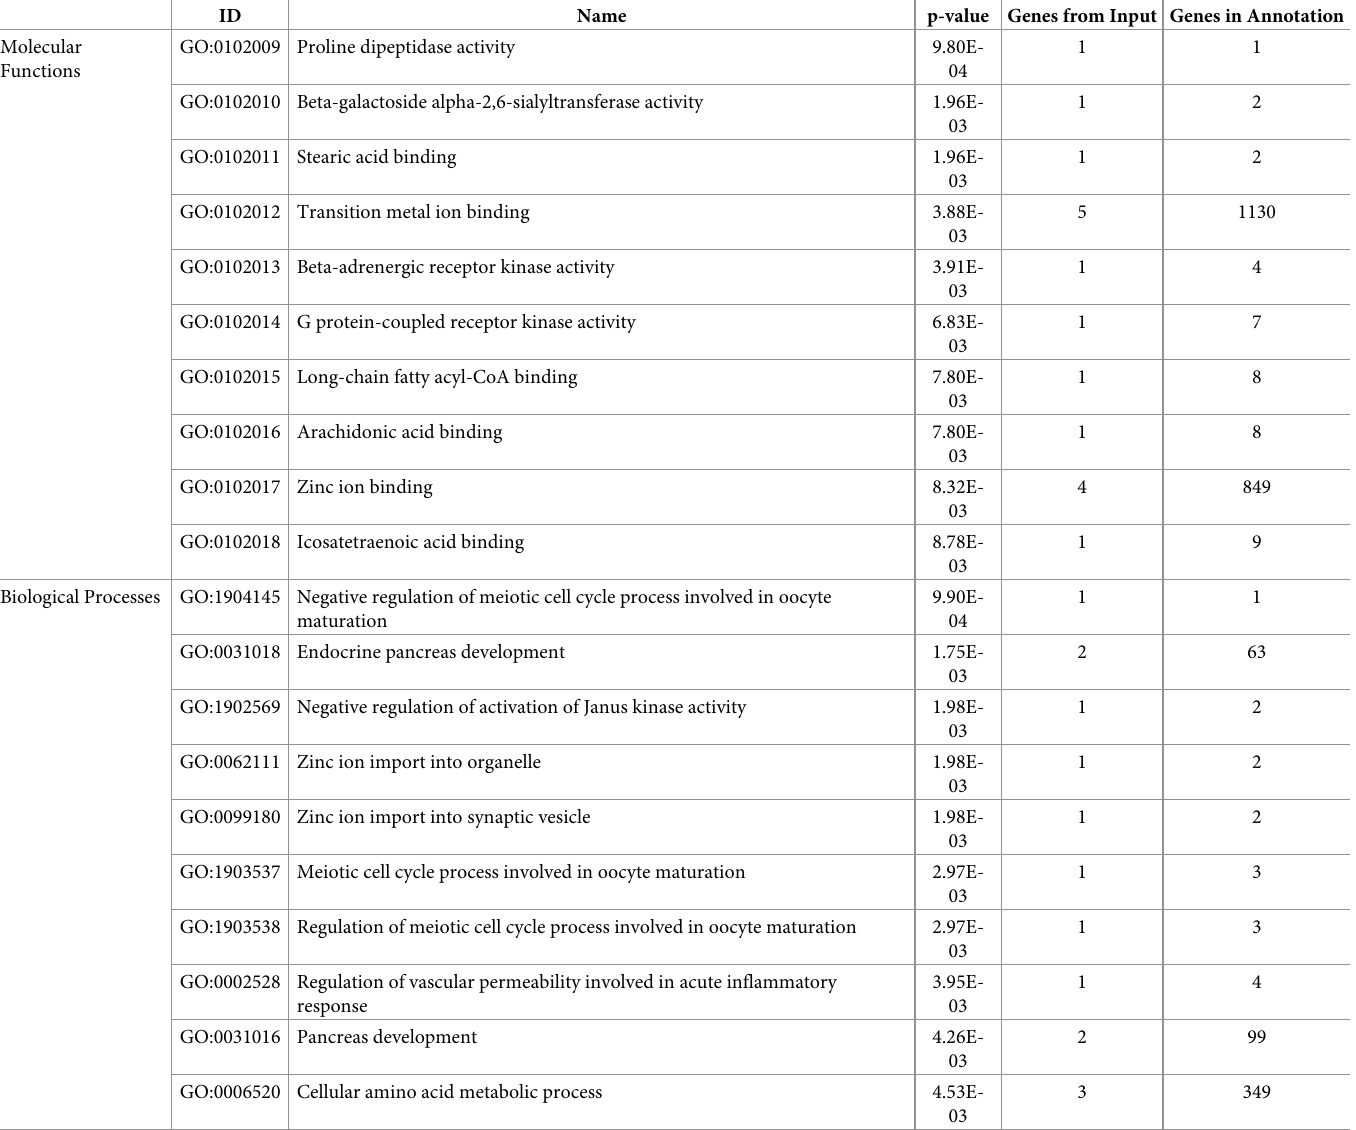
Table 2. The most significant gene ontology (GO) terms for type 2 diabetes associated SNPs target genes. ID Name p-value Genes from Input Genes in Annotation Molecular